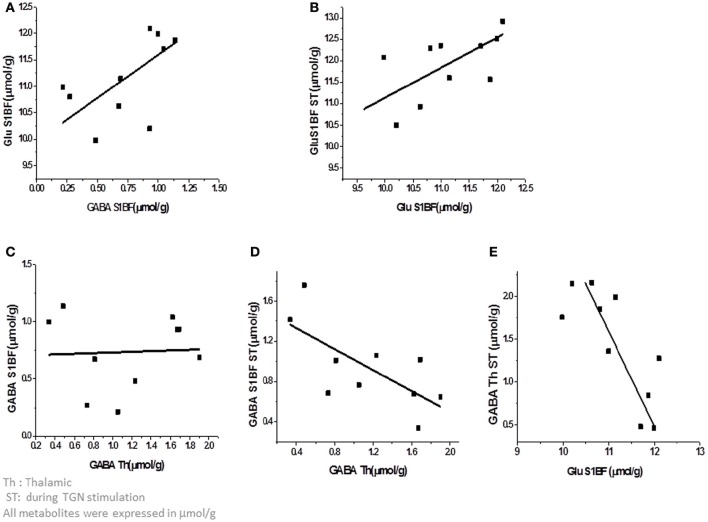
Correlations between metabolites within and between the thalamus and the cortex. (A) At rest, GABA and Glu levels in the barrel cortex were positively correlated (Pearson's r = 0.74; P = 0.014). (B) In S1BF, Glu levels at rest and during stimulation were correlated (Pearson's r = 0.67; P < 0.05) (C,D). Thalamic GABA levels at rest were negatively correlated to barrel cortex GABA levels during stimulation (Pearson's r = −0.69; P = 0.024) but not at rest (Figure 4C). (E) Glu levels in S1BF at rest were strongly influenced by stimulated thalamic GABA levels.